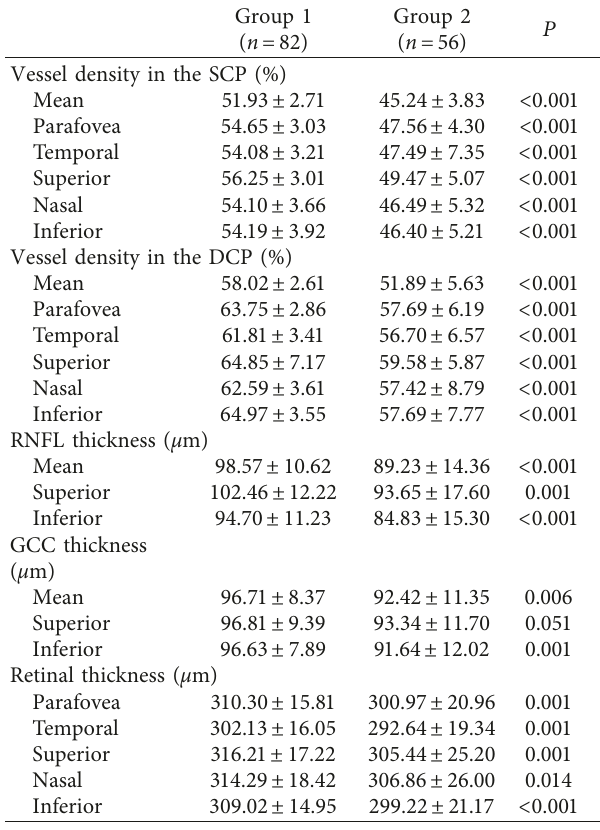
Table 2: Comparison of the vessel density, retinal nerve fiber layer, ganglion cell complex, and retinal thickness in patients with early dry-type myopic